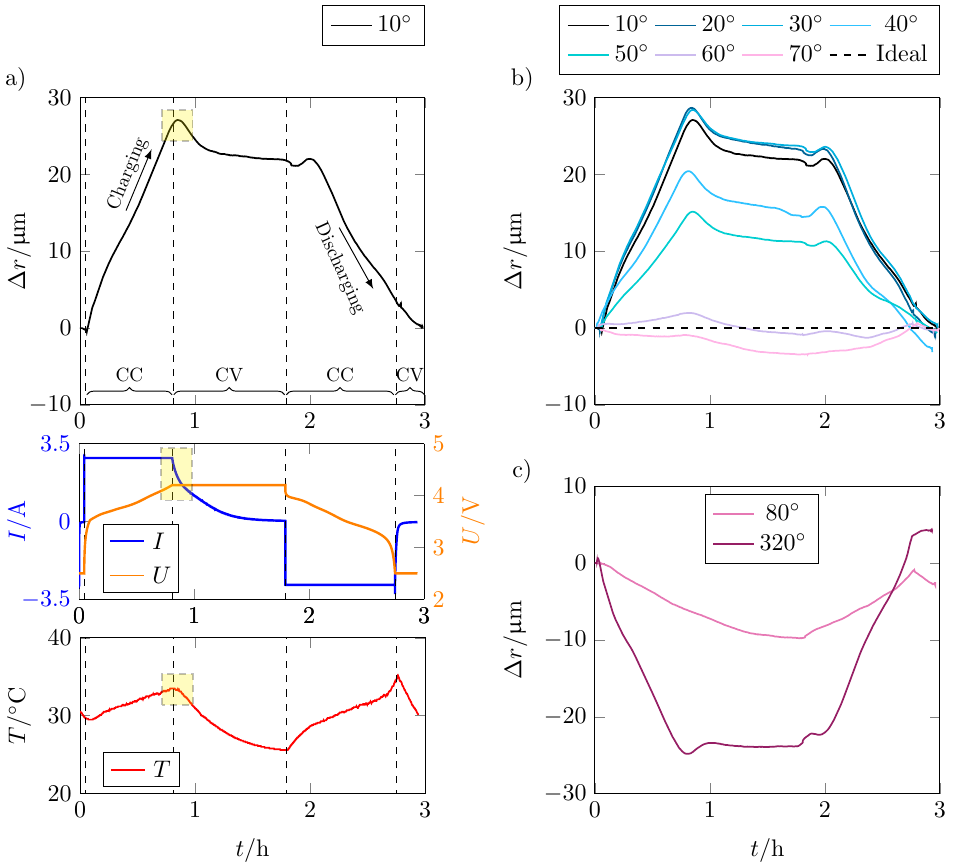
Figure 6. ( a ) Radial expansion ∆ r in µ m of the LG INR18650 M29, the corresponding current I in A and voltage U in V, and the temperature T in ◦ C over the time t in h for charge and discharge cycle for position 1 ( α = 10 ◦ from the current collector tab). The area highlighted in yellow marks the end of the CC phase or the beginning of the CV phase at which the temperature inside the cell continues to increase despite the falling current, resulting in a change of the cell thickness; ( b ) radial expansion ∆ r in µ m of position 1–7 ( α (cid:101) { 10,20,...,70 } ◦ ) from the current collector tab; ( c ) comparison of the radial expansion of position 8 and 32 with negative expansion over the charge and discharge